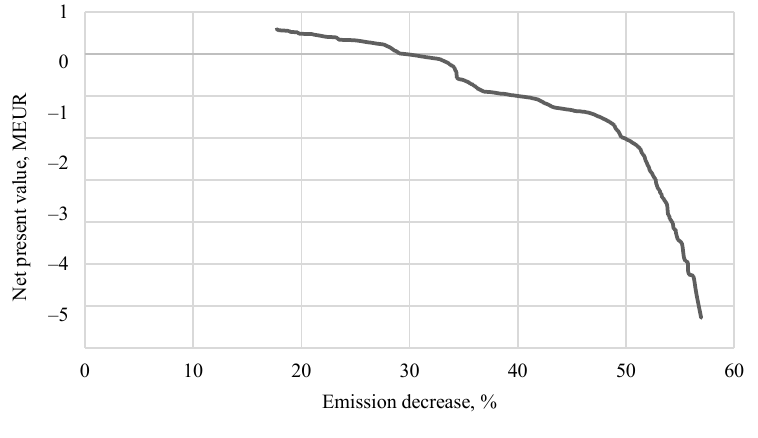
Fig. 4. Pareto-optimal solutions in terms of net present value and emission reduction